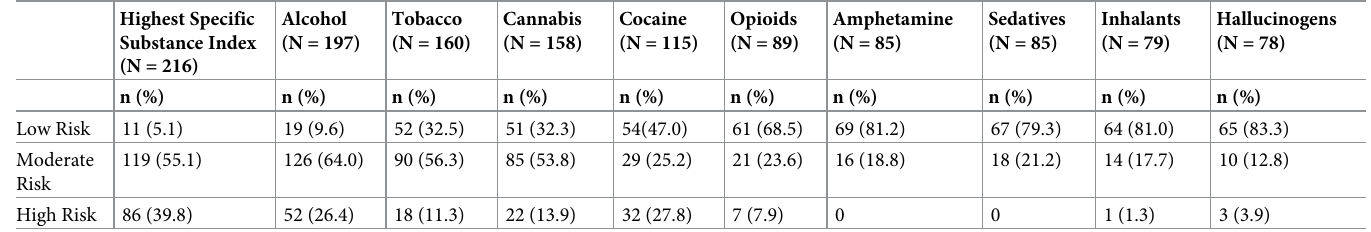
Table 2. Substance use risk